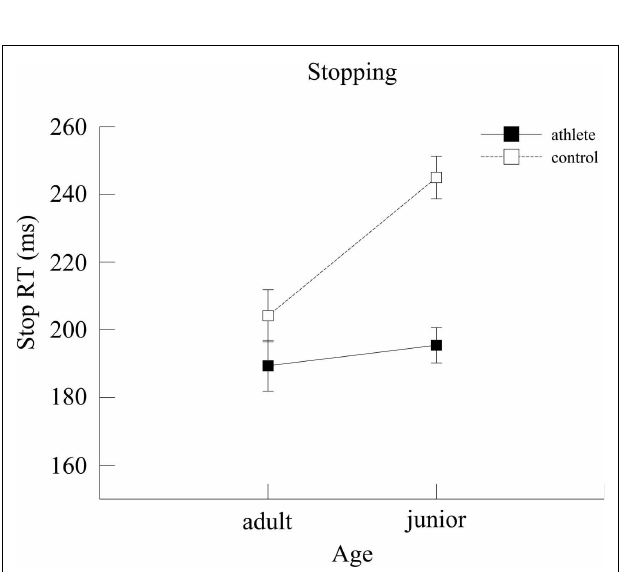
FIGURE 3 | Stop reaction time (ms) for the two groups as a function of age. Error bars represent ± 1 standard error.